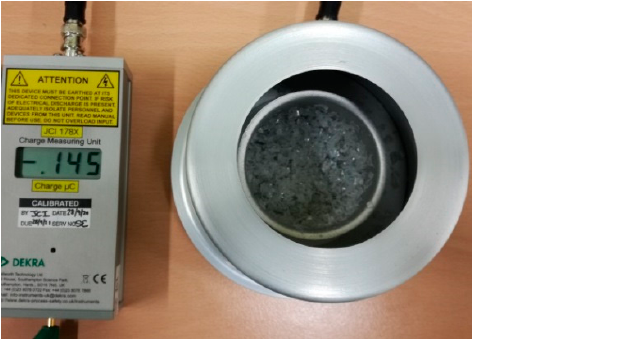
Figure 8. A system for measuring the accumulated charge on particles of ( a ) PET and ( b ) PE-HD polymers.